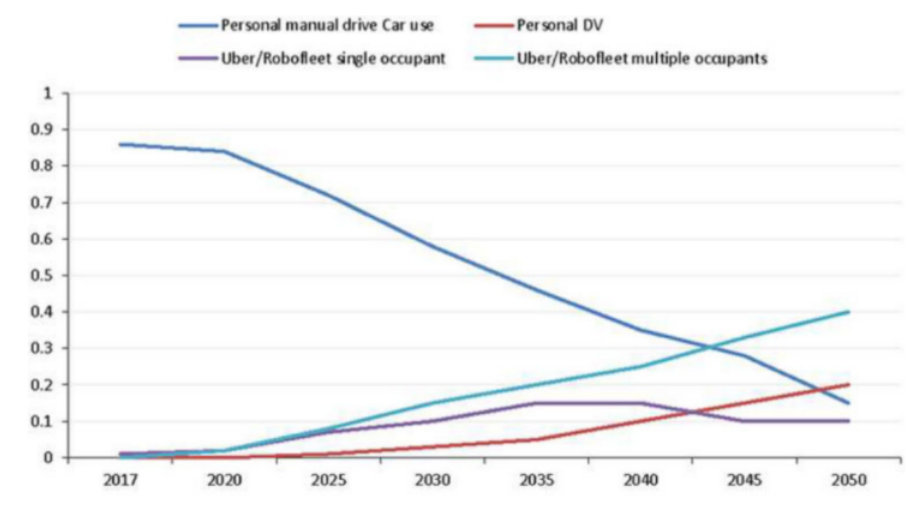
Figure 1. Forecast of smart vehicle development (adapted from [9]).